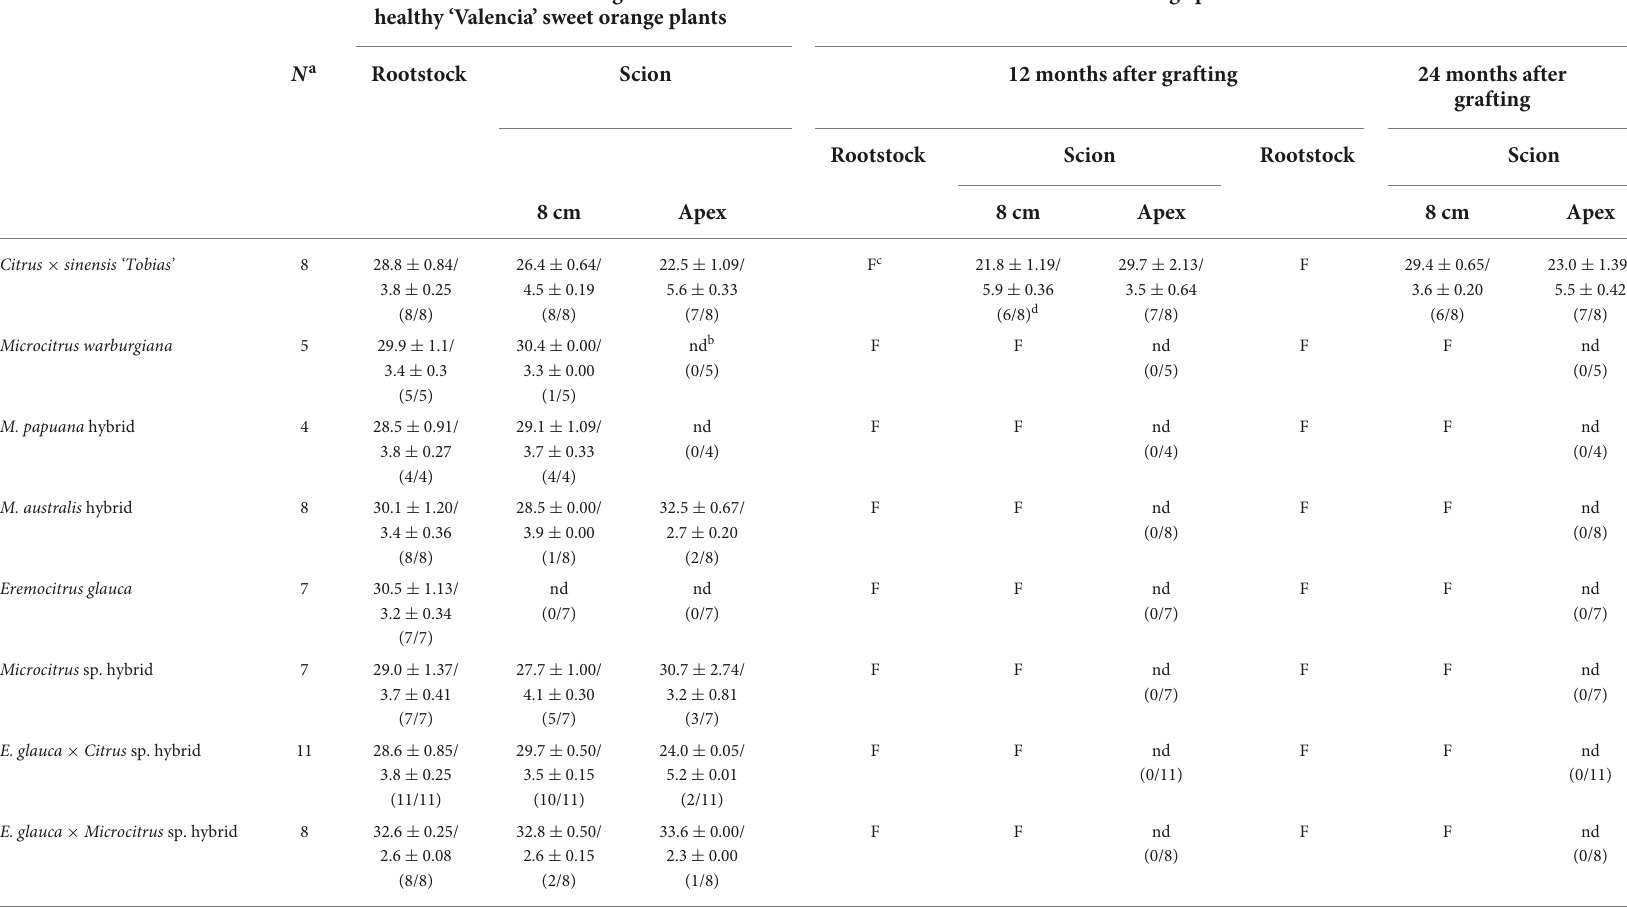
TABLE 4 ‘ Candidatus Liberibacter asiaticus’ (Las) infection, determined by quantitative polymerase chain reaction, in bark patches and budwood collected from different regions (8 cm above the graft union and at the top, respectively) of Oceanian citrus and ‘Tobias’ sweet orange plants, as well as from the stem (5 cm below the graft union) of Las-infected ‘Rangpur’ lime used as rootstock, graft success and Las transmission from those bark patches and budwood to ‘Valencia’ sweet orange plants, 12 and 24 months after